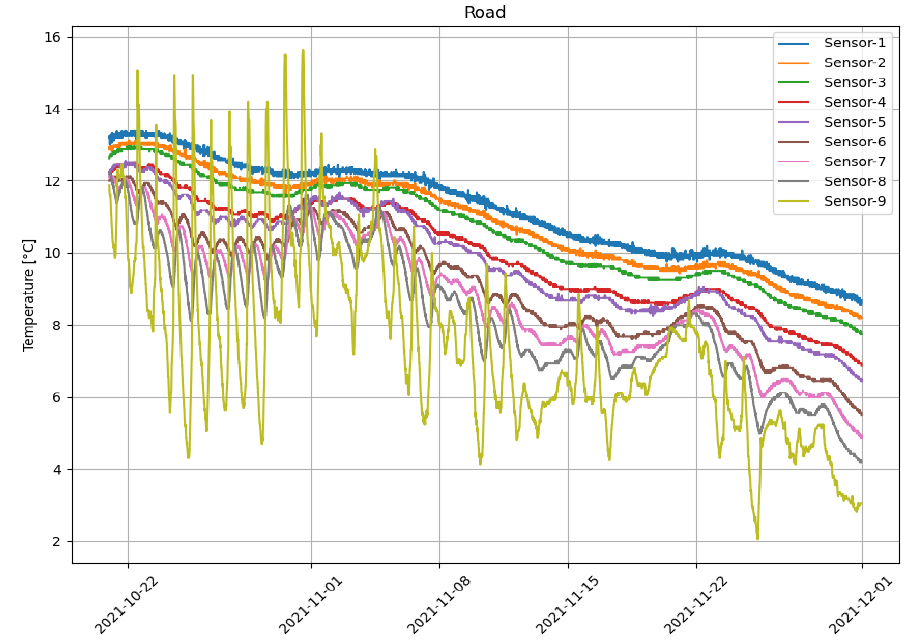
Figure 25. Temperature measurements October – December 2021.